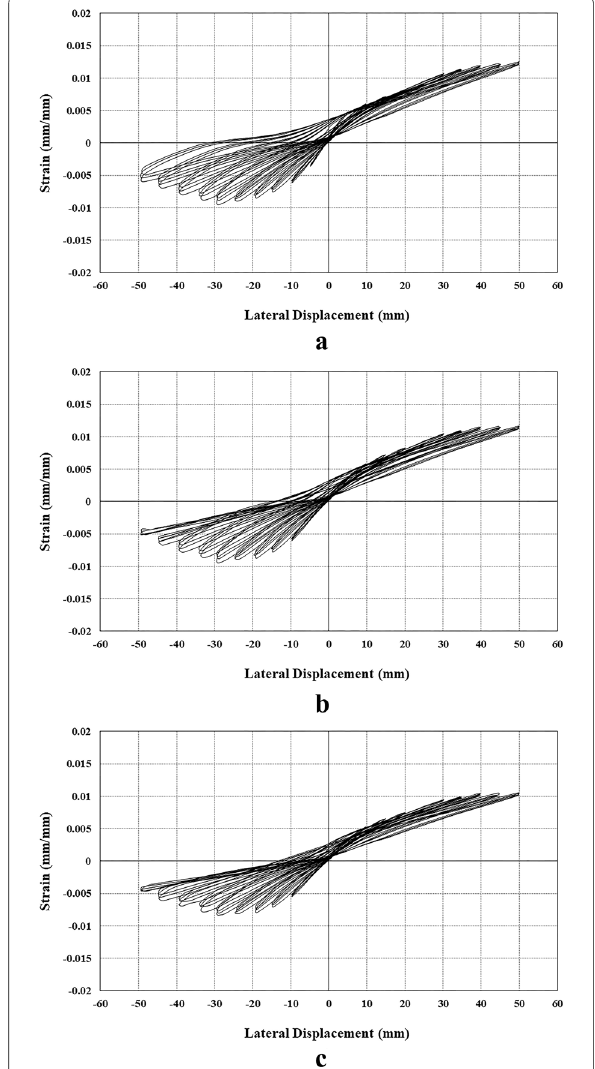
Fig. 8 Relationship between the lateral displacement–strain on the strain gauge SF2 of GFRP bars: a S08; b S10; c